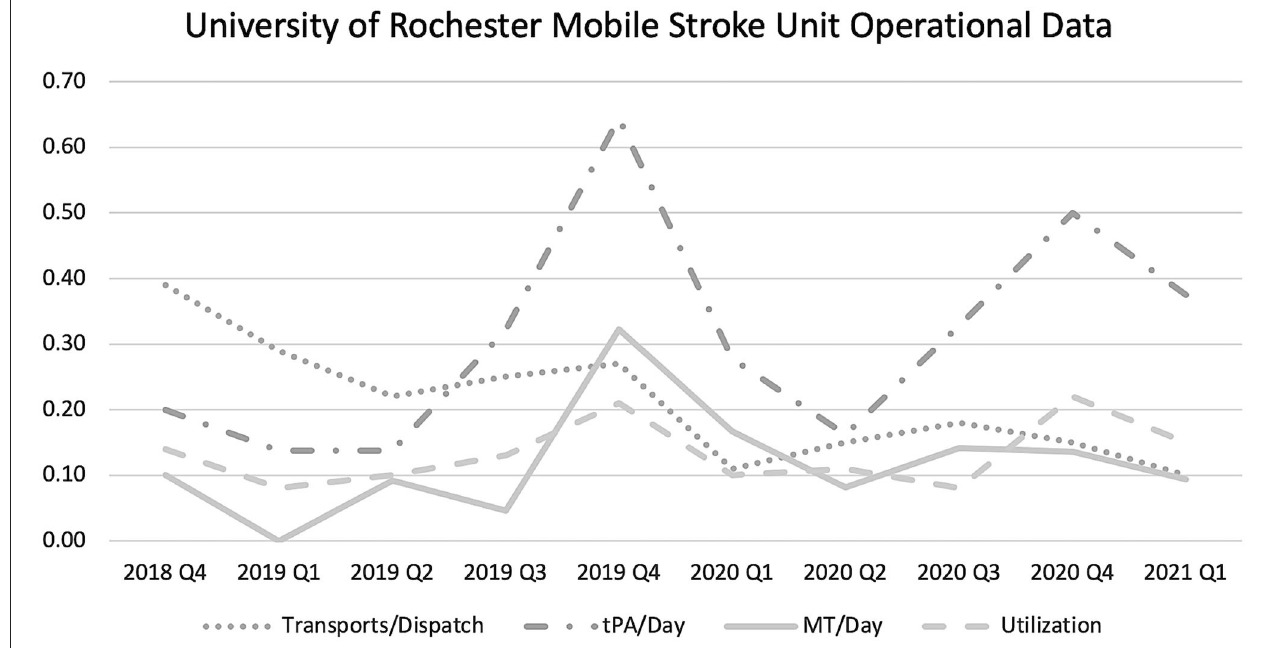
FIGURE 2 | University of Rochester Medical Center Mobile Stroke Unit Operational Data. The data shown here outlines the mobile stroke unit experience at the University of Rochester from its inception in October of 2018, through March of 2021. tPA, tissue plasminogen activator; MT, mechanical thrombectomy.